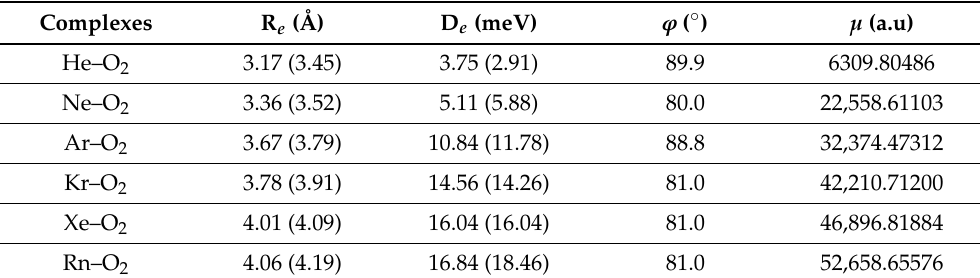
Table 1. Geometric parameters ( R e and ϕ ) of the most stable configurations and corresponding energies ( D e ) of the Ng–O 2 complexes. The values in parentheses refer to the results available in the literature which were determined via the ECF approach [9,22] (see text for more details). The µ reduced masses of each complex are also